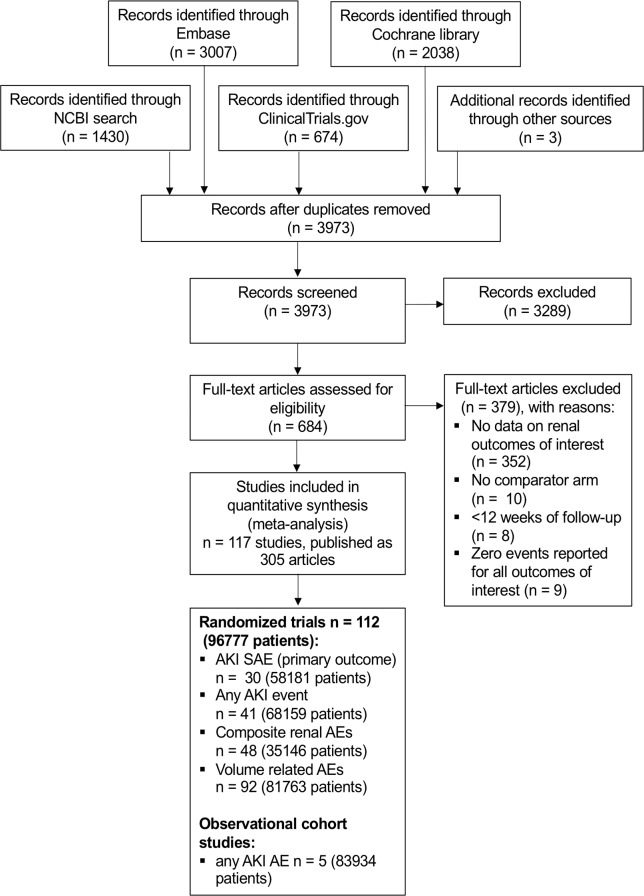
PRISMA diagram.AE, adverse event; AKI, acute kidney injury; NCBI, National Center for Biotechnology Information; PRISMA, Preferred Reporting Items for Systematic Reviews and Meta-Analyses; SAE, serious AE.